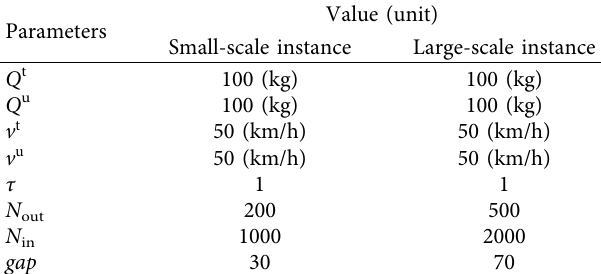
Table 2: Values of involved parameters.